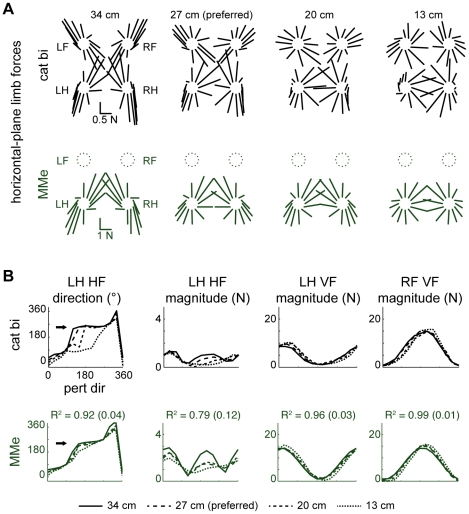
Limb forces predicted by optimal task-level control of CoM force and moment.
A: average horizontal plane forces observed in each postural configuration of cat bi (black) compared with model MMe predictions (green). Force vectors are drawn for each limb (clockwise from top left: LF, left forelimb; RF, right forelimb; RH, right hindlimb; LH, left hindlimb) with their origins offset in the direction of platform motion. Stance distance decreases from left to right. Predicted forces were directed towards and away from the CoM, characteristic of the force constraint strategy described previously [18] at longer stance distances (34 and 27 cm), whereas a wider range of force directions was observed at shorter stance distances (13 cm) [53]. B: comparison of average and predicted limb force components in polar coordinates. HF, horizontal force; VF, vertical force. Predicted horizontal plane forces reproduced the region of invariant force directions for perturbation directions that unloaded the hindlimb (180° to 270°) observed at longer stance distances (34 and 27 cm) (arrows).